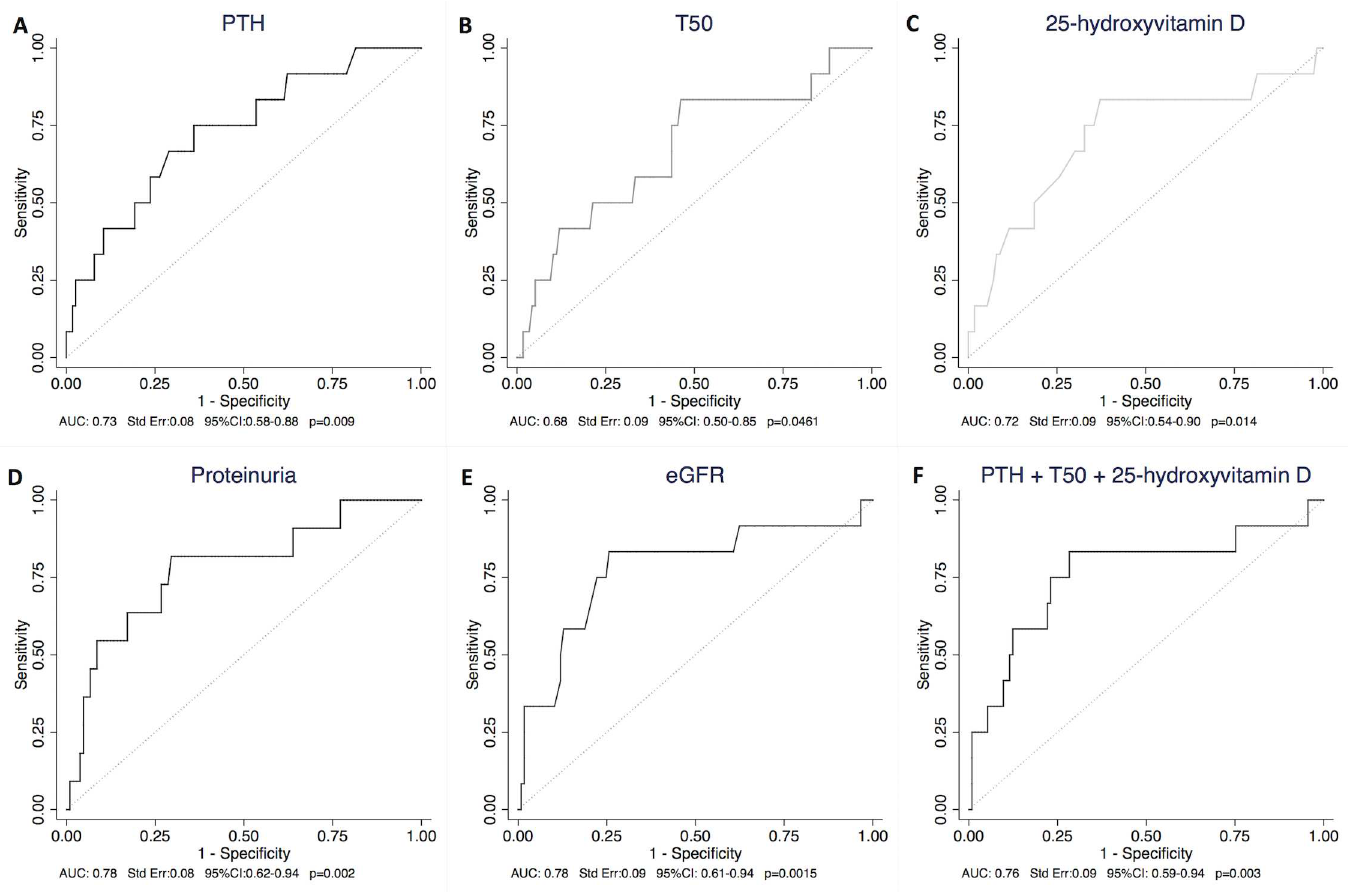
Fig 3. ROC curves of T 50 , 25D, PTH, proteinuria and eGFR in predicting Fibrosis > 40%. As T 50 , vitamin D and eGFR are markers that are negatively associatedwith fibrosis, we used the oppositevalues of those markers. ( 3A-B-C-D-E) SeparateROC curves for ln PTH, T 50 , 25D, proteinuriaand eGFR ( 3F ) ROC curve for ln PTH, 25D and T 50 combined.25D: 25-hydroxyvitamin D; AUC: Area Under the Curve; eGFR: estimated GlomerularFiltration Rate; Ln: log- transformed; PTH: parathyroidhormone; ROC: ReceiverOperatingCharacteristic; T 50 : Calcificationpropensity.